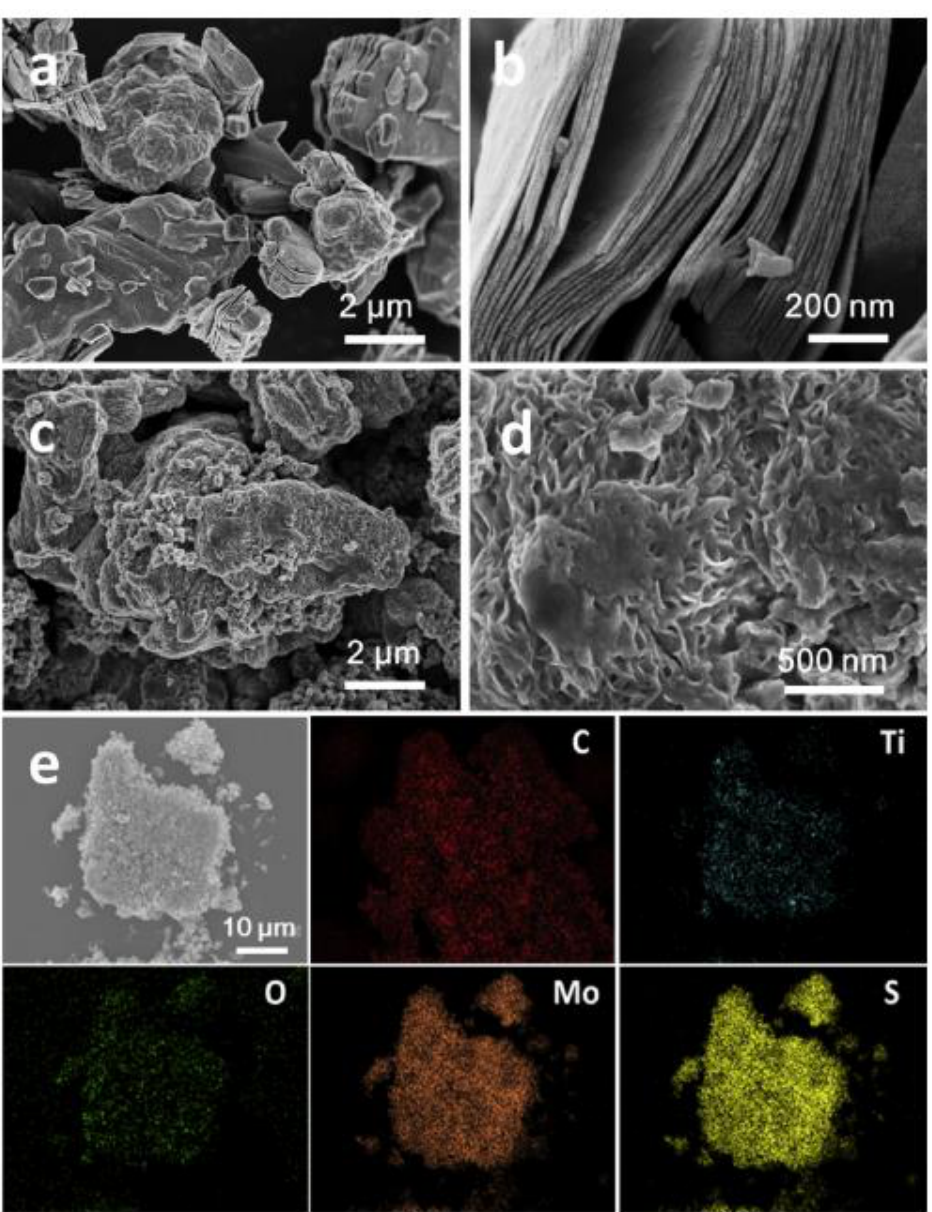
Figure 5. SEM images of Ti 3 C 2 nanosheets ( a , b ) and MoS 2 /Ti 3 C 2 heterostructures ( c , d ). Elemental mapping images ( e ) of MoS 2 /Ti 3 C 2 heterostructures. Adapted with permission from [176], Copyright 2019, Elsevier.